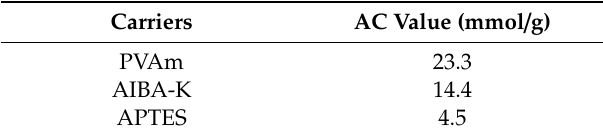
Table 2. Calculated amine concentration (AC) values for amine carriers.